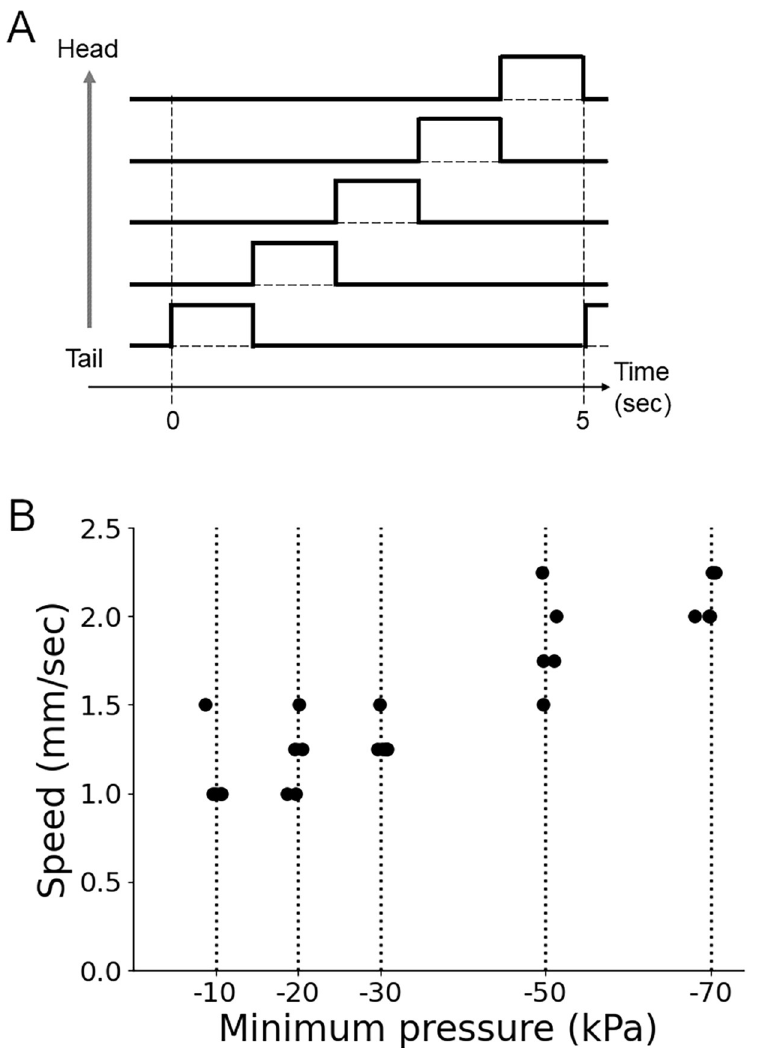
10 − 7 by one-way